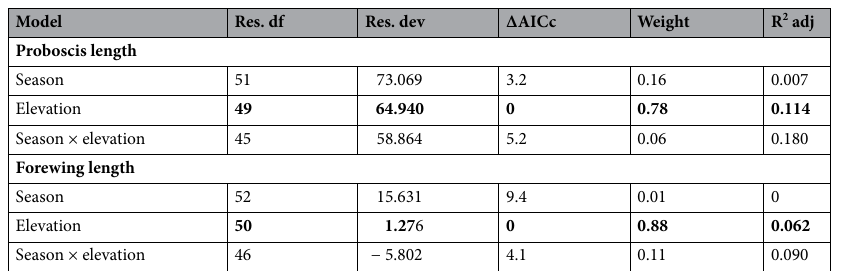
Table 3. Linear model comparison of the individual effects of season and elevation, and their interaction, on proboscis and forewing length of lepidopterans on Mount Cameroon. ‘ res. df ’ and ‘ res. dev. ’ represent the residual’s degrees of freedom and deviance,